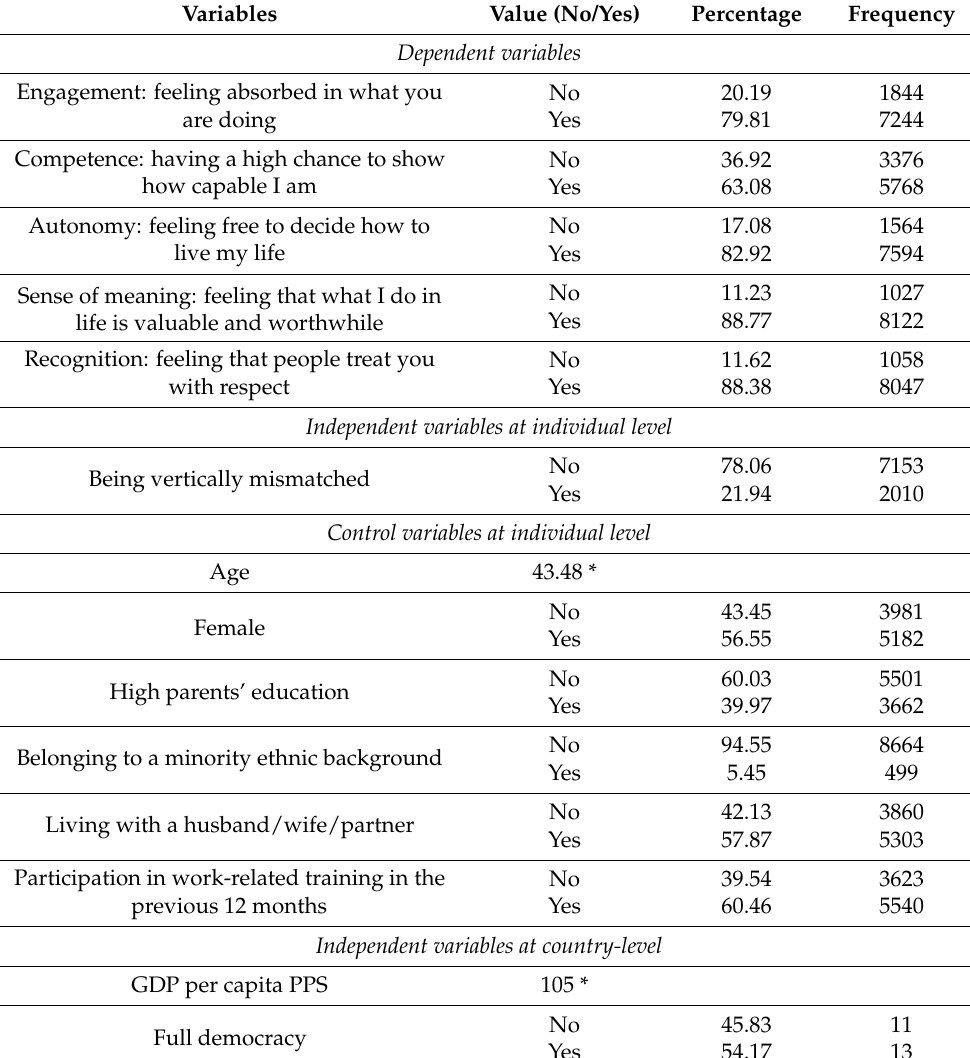
Table A1. Descriptive statistics of all variables analysed after listwise deletion of individual-level independent and control